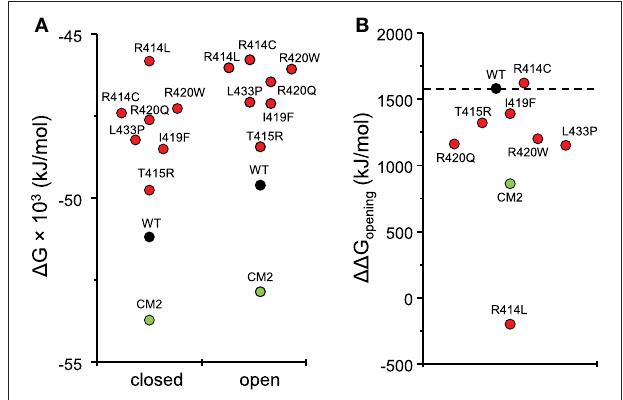
FIGURE 5 | Energies of wild type and mutant NTRs in the closed and open state. (A) Energies of individual molecules in the closed and open state; (B) opening energies of individual